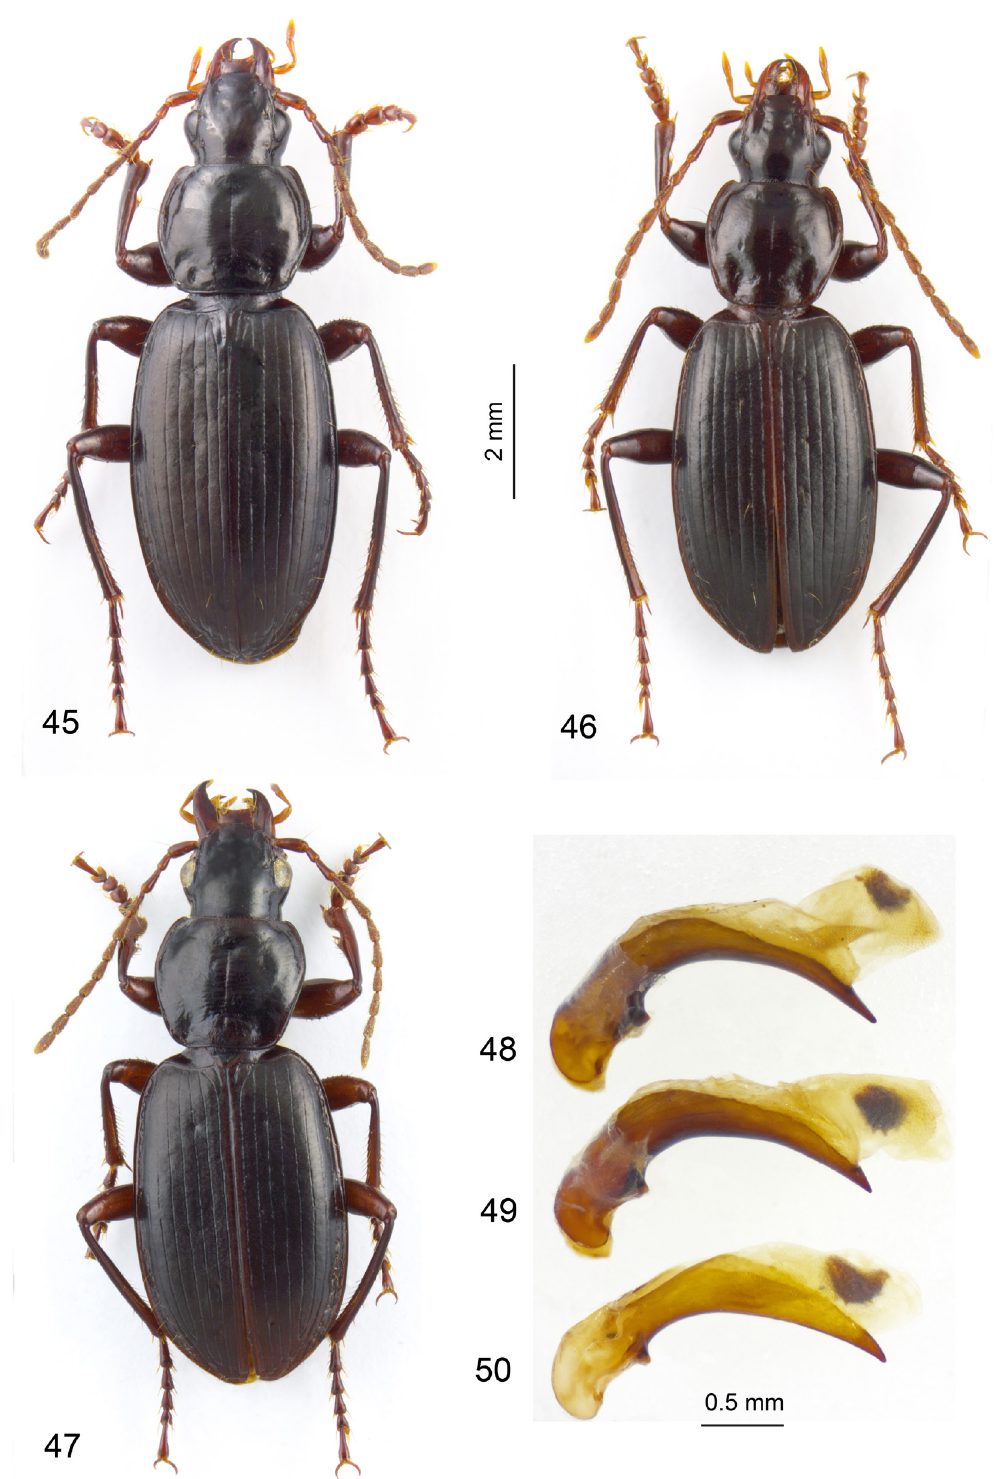
Figs 45–50. Dyscolus spp., habitus (45–47) and aedeagus, median lobe in lateral view